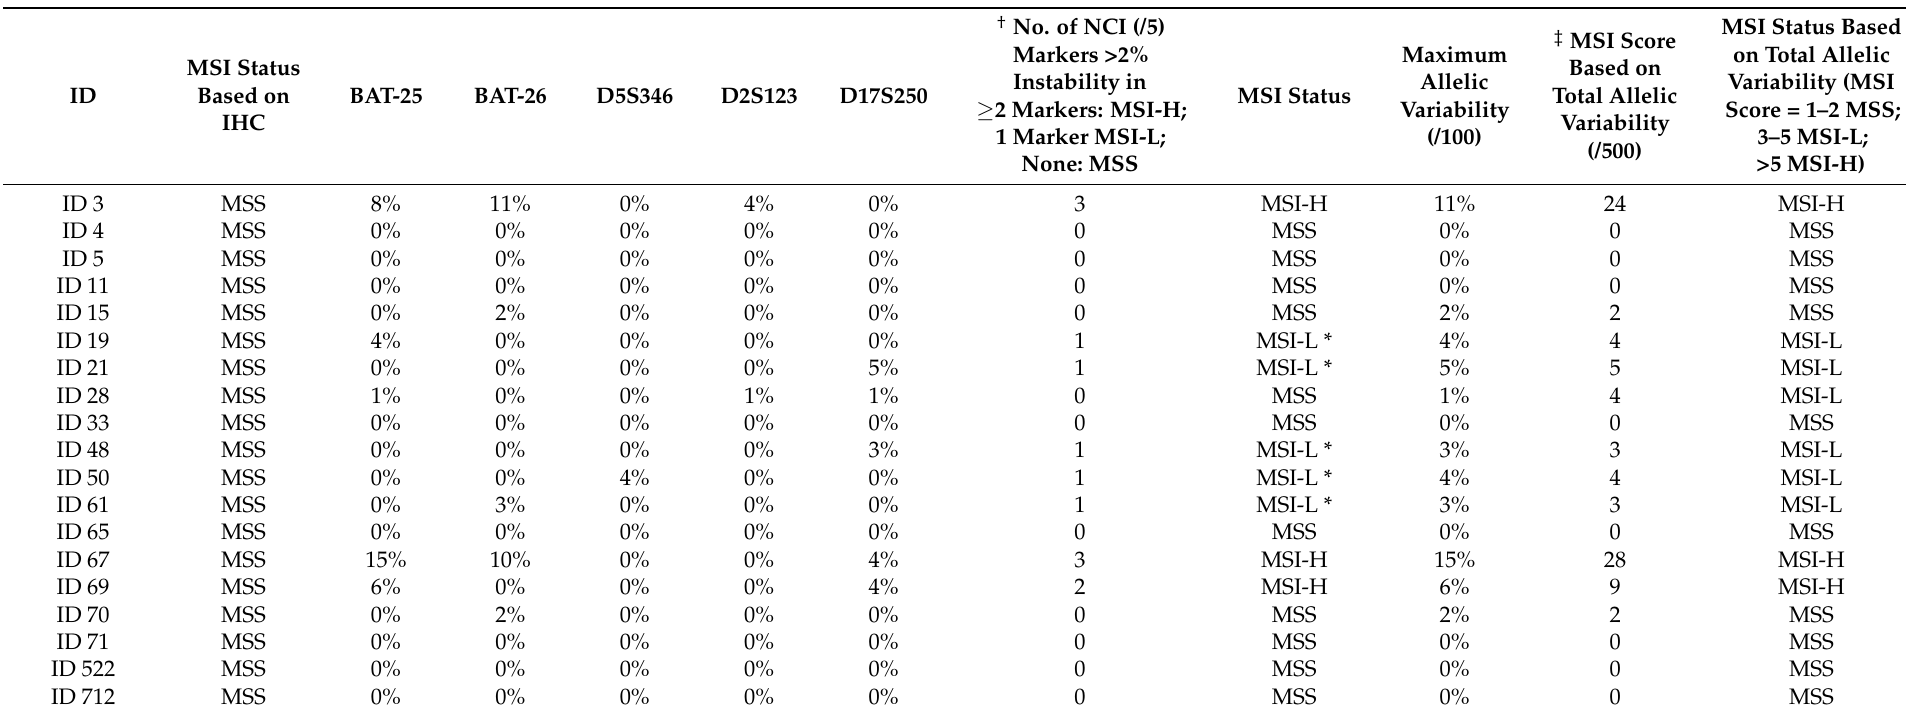
Table 7. Correlation between MSI status detection using high-resolution capillary electrophoresis with (a) traditional analysis and (b) MSI score based on total allelic variability, compared to immunohistochemistry (IHC) for MSS tumours from patient